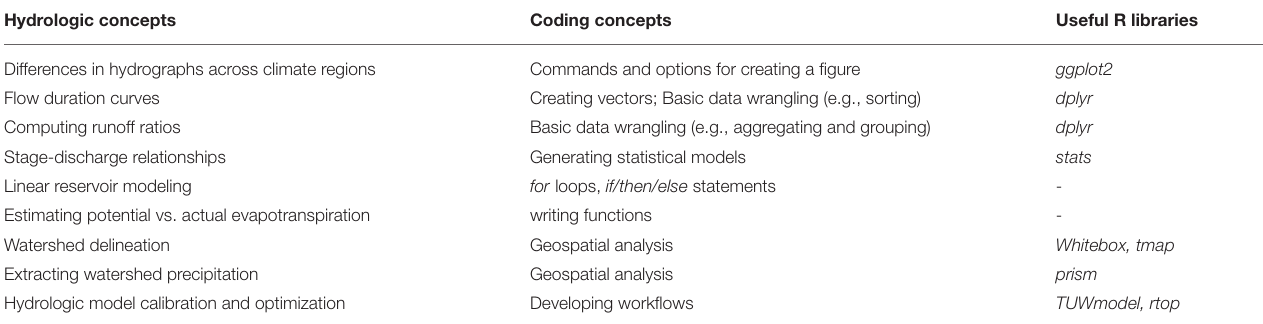
TABLE 2 | Matching hydrologic concepts with coding concepts in a hydrology